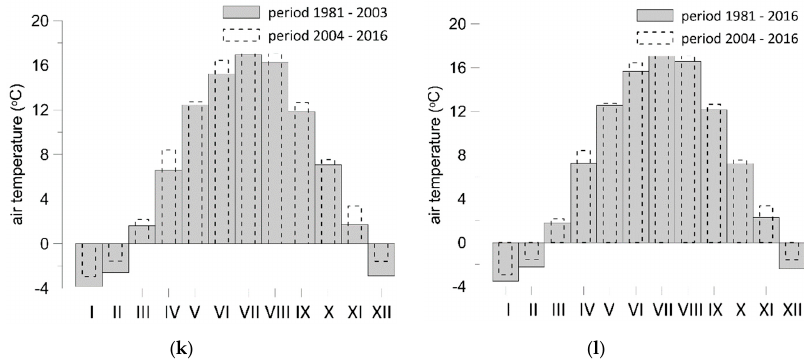
Figure 5. ( a – i ) Analysis of the hydrometeorological data–Boca River basin. ( a ) time series of annual discharges–average (black line), minimum (red line); ( b ) box plot of monthly discharges (1981–2016);